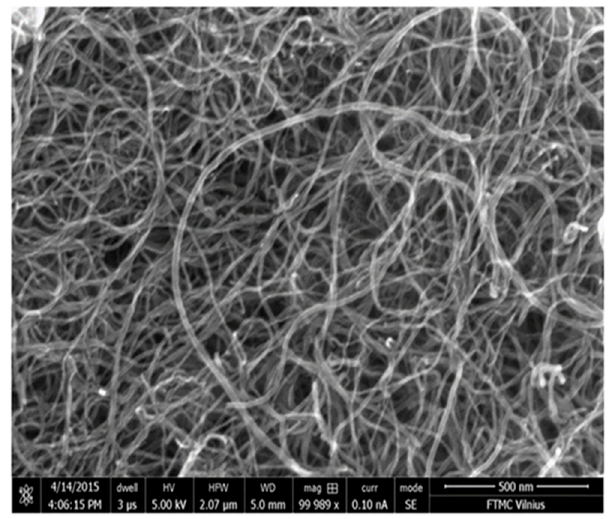
Figure 1. SEM image of carbon nanotube-based nanostructure.